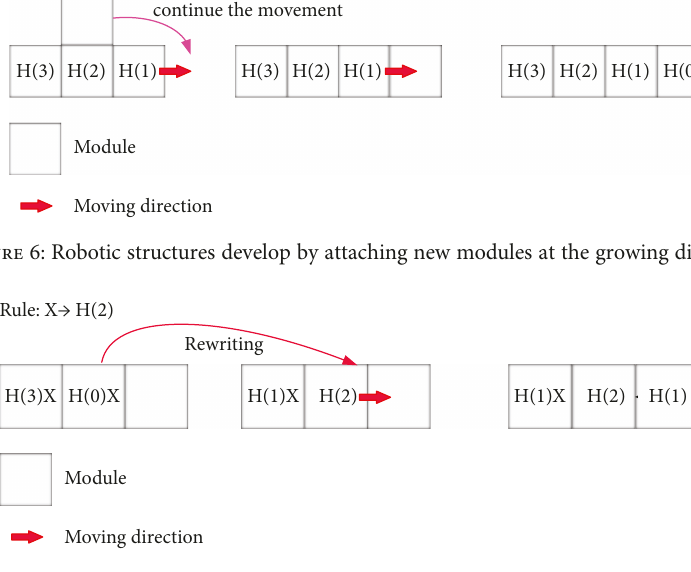
Figure 7: Decentralized rewriting work by independent